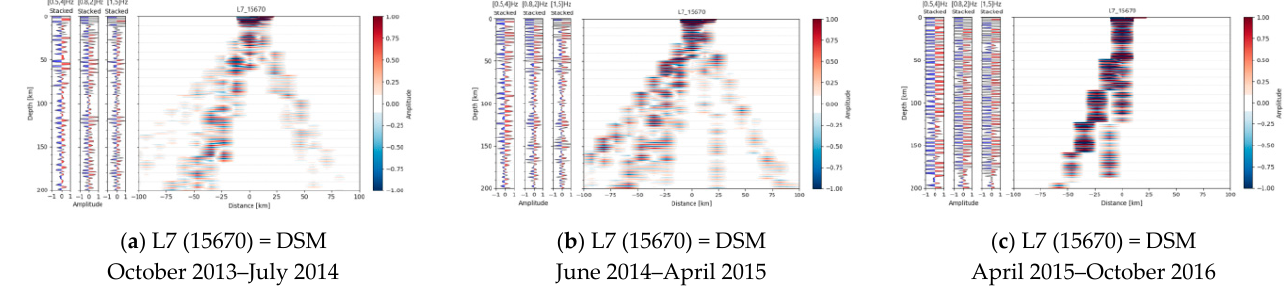
Figure 20. Variation characteristics of underground structure of 15670 (DSM) in different time peri- ods.